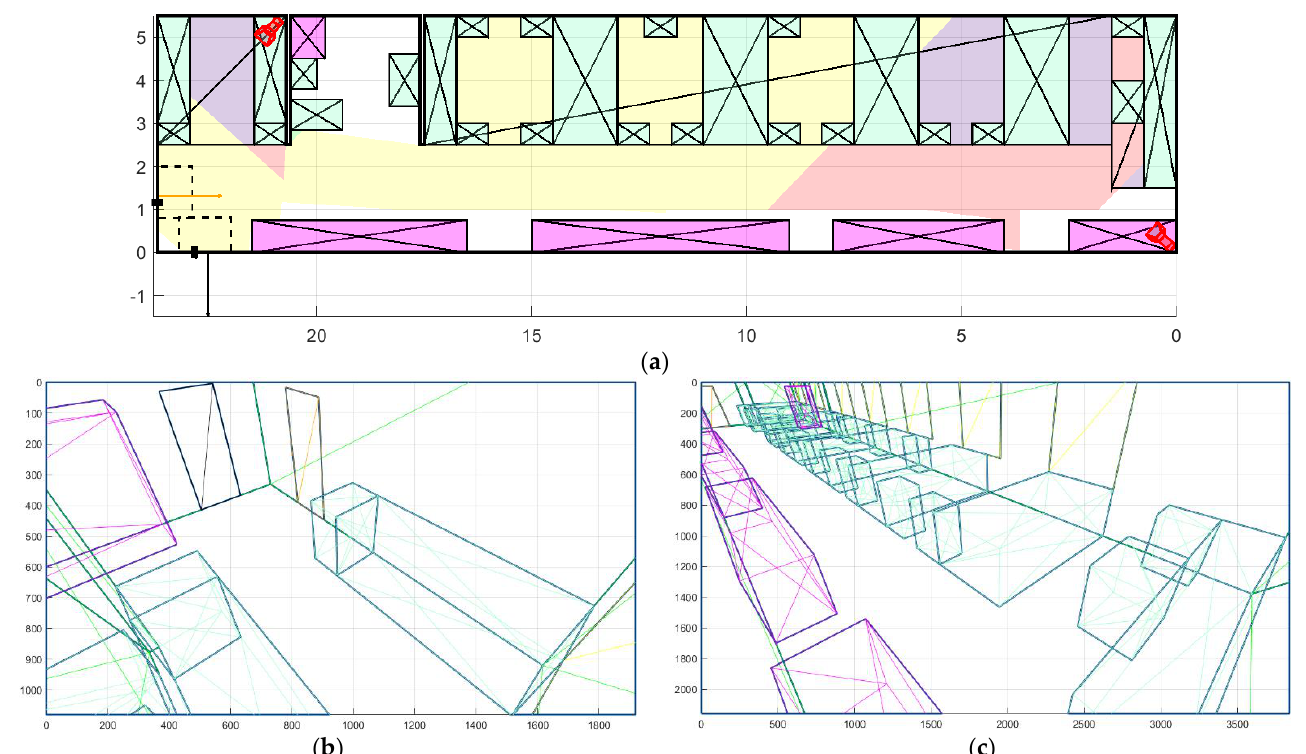
Figure 14. Placement of cameras without taking into account the windows in the room 2: ( a ) floor plan; ( b ) view from the first camera; and ( c ) view from the second camera.